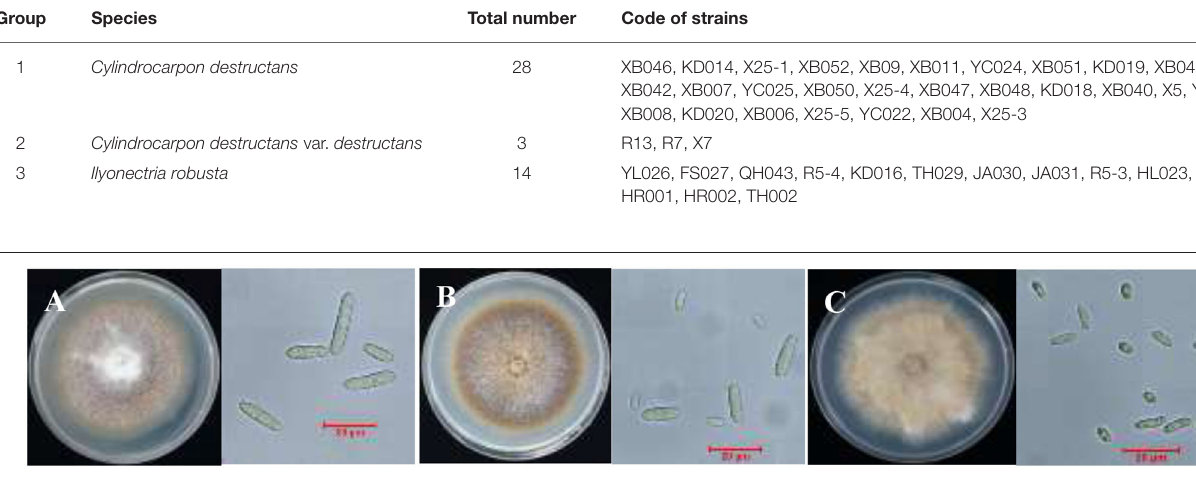
FIGURE 3 | Typical colonies and macroconidia of Cylindrocarpon isolated from ginseng root rust rot. (A) Cylindrocarpon destructans ; (B) C. destructans var. destructans ; (C) Ilyonectria robusta